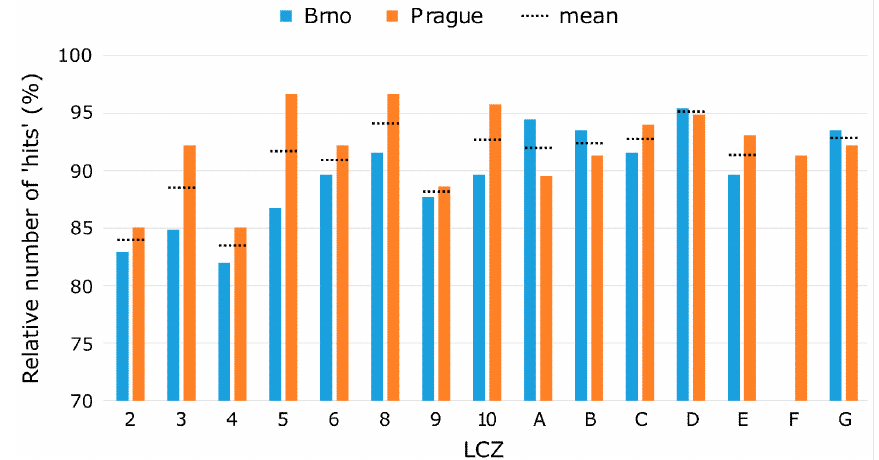
Figure 11. Relative number of multiple comparison tests indicating significant differences ( p < 0.05) in LST (“hits”) among LCZs in Brno and Prague; LCZ F does not occur in Brno; dotted lines indicate mean values for the two cities.